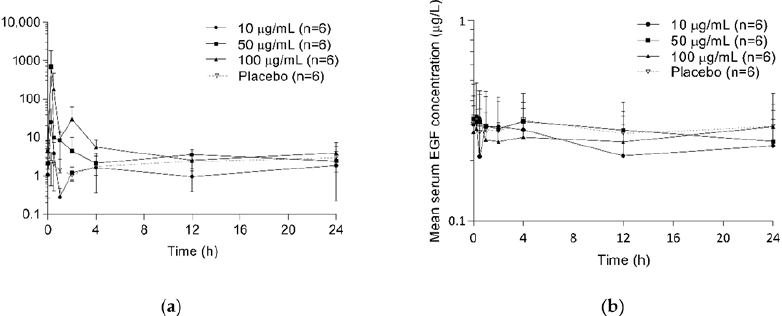
Figure 1. Mean EGF concentration-time curves after single administration of rhEGF eyedrops: ( a ) tear; ( b ) serum.